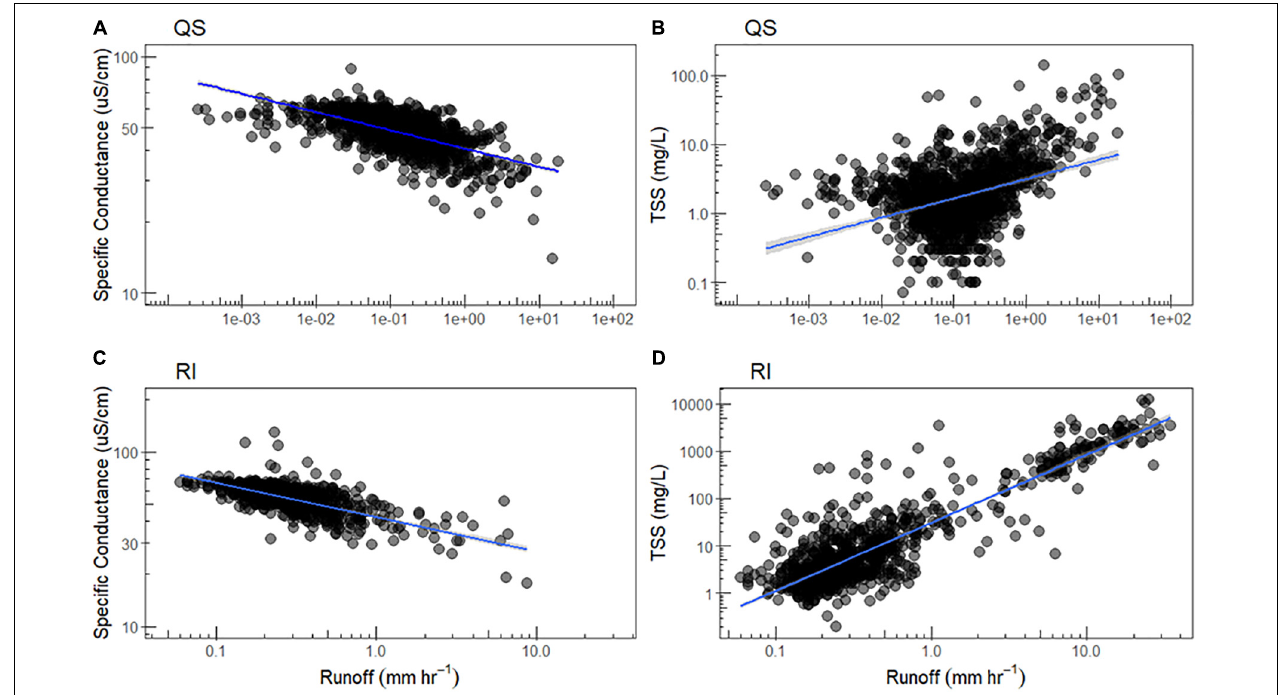
FIGURE 5 | Long-term concentration-discharge (C-Q) response of specific conductance and total suspended sediment (TSS) in Quebrada Sonadora (QS: A,B ) and Rio Icacos (RI: C,D ). Note that both axes are